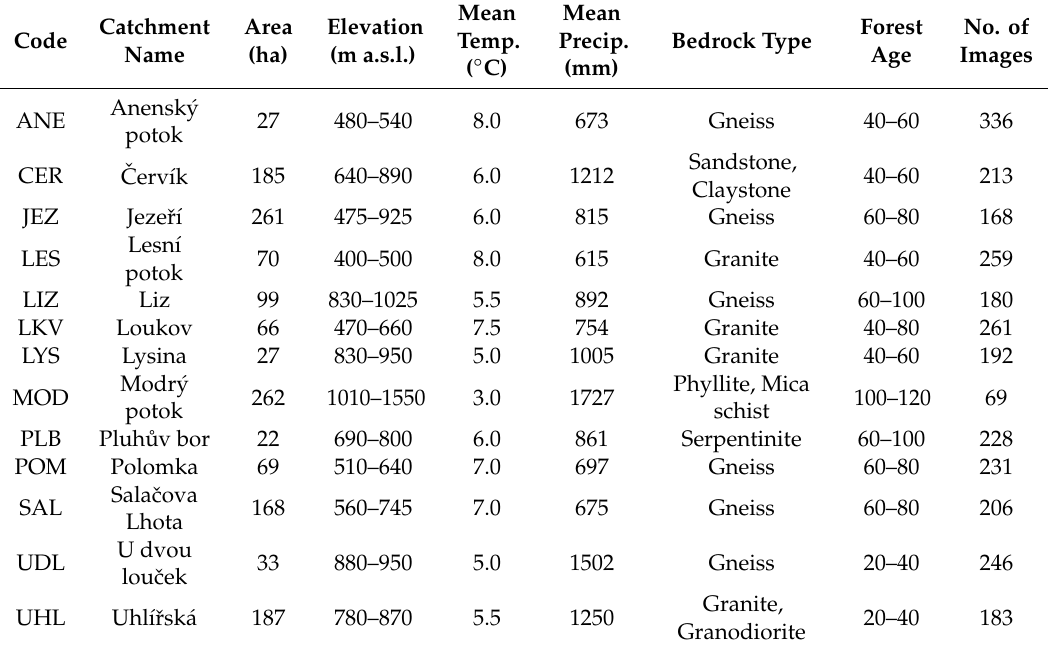
Table 1. Characteristics of GEOMON stream catchments in this study and the number of cloud-free Landsat images for the period 1984-2016 that were used to compute annual